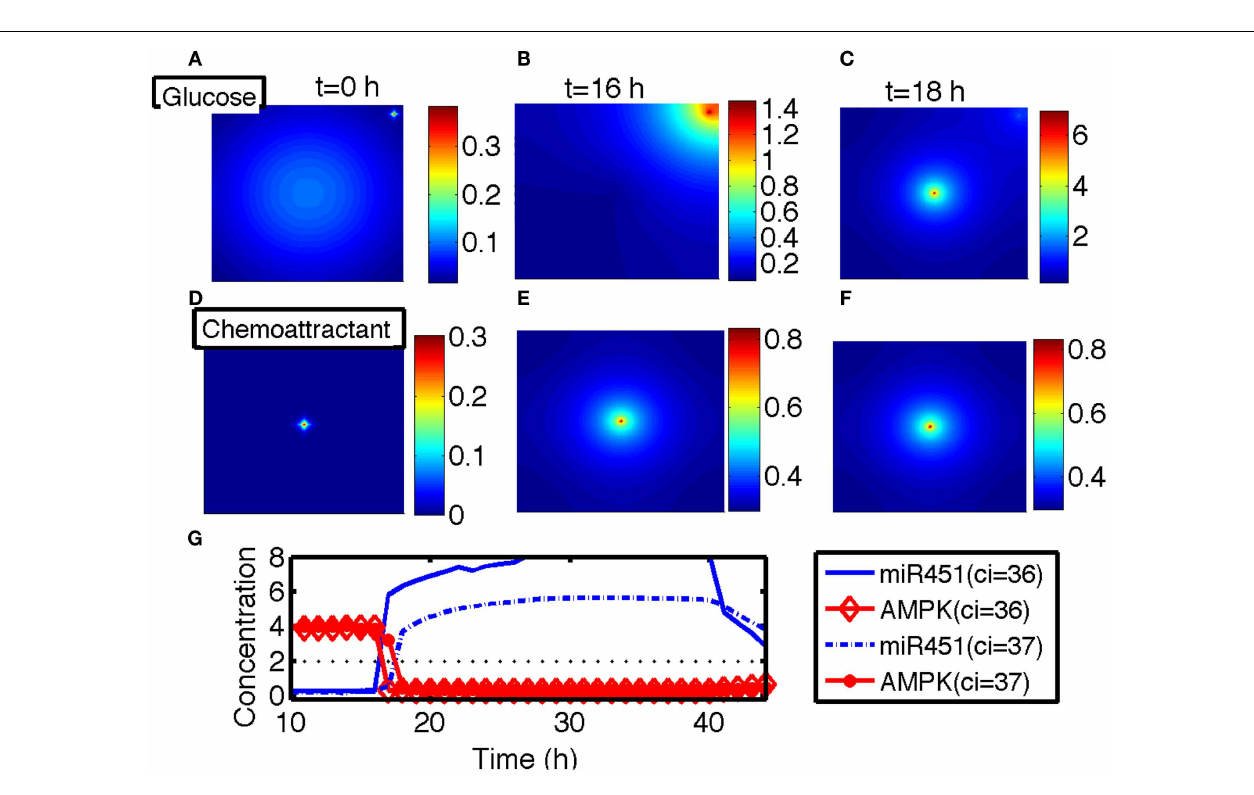
profiles of chemoattractant at t = 0, 16, 18h. Chemotactic source was located at the center of the domain. (G) Time course of the miR-451 activity and AMPK level at two cell sites (cell id = 36, 37). *Domain size in (A–F) = [0, 1] 2 .